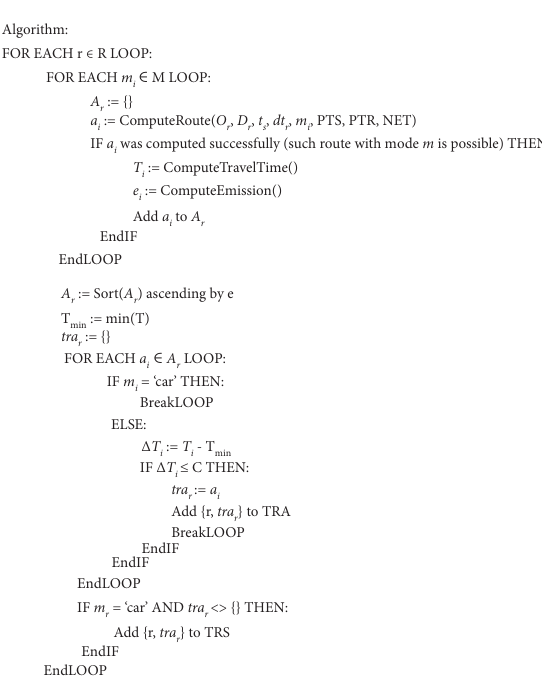
Figure 1: Identifying time-relevant low-carbon